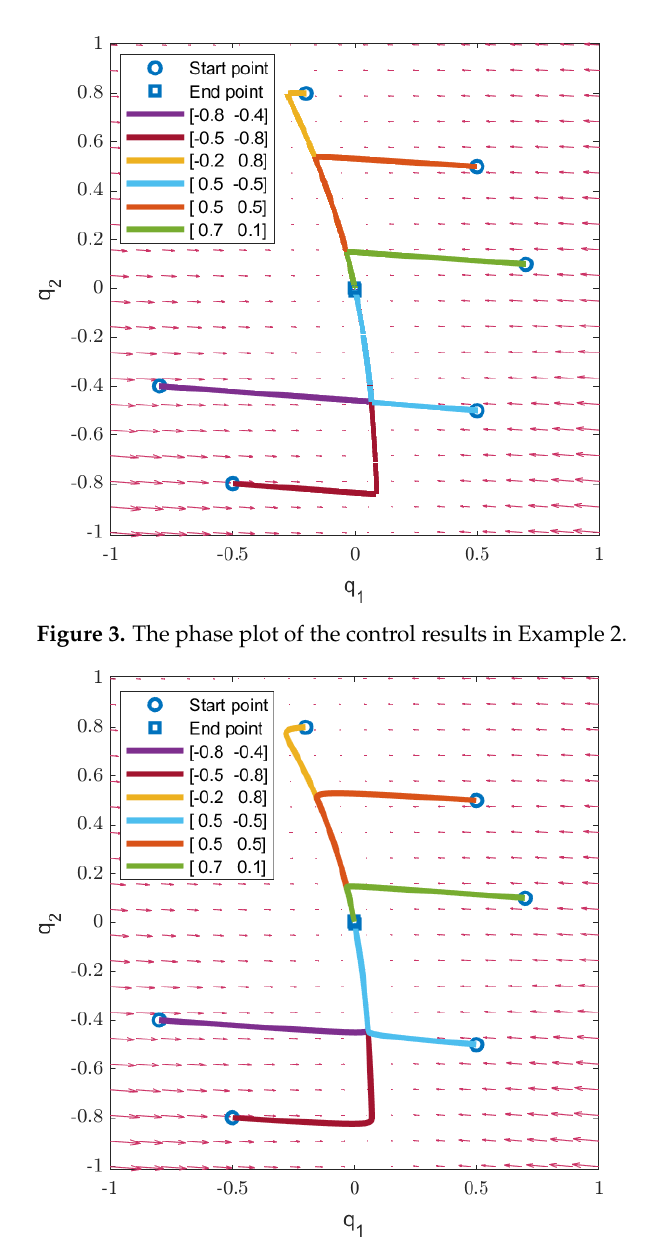
Figure 4. The phase plot of the control results which exchanging A 1 and A 2 in Example